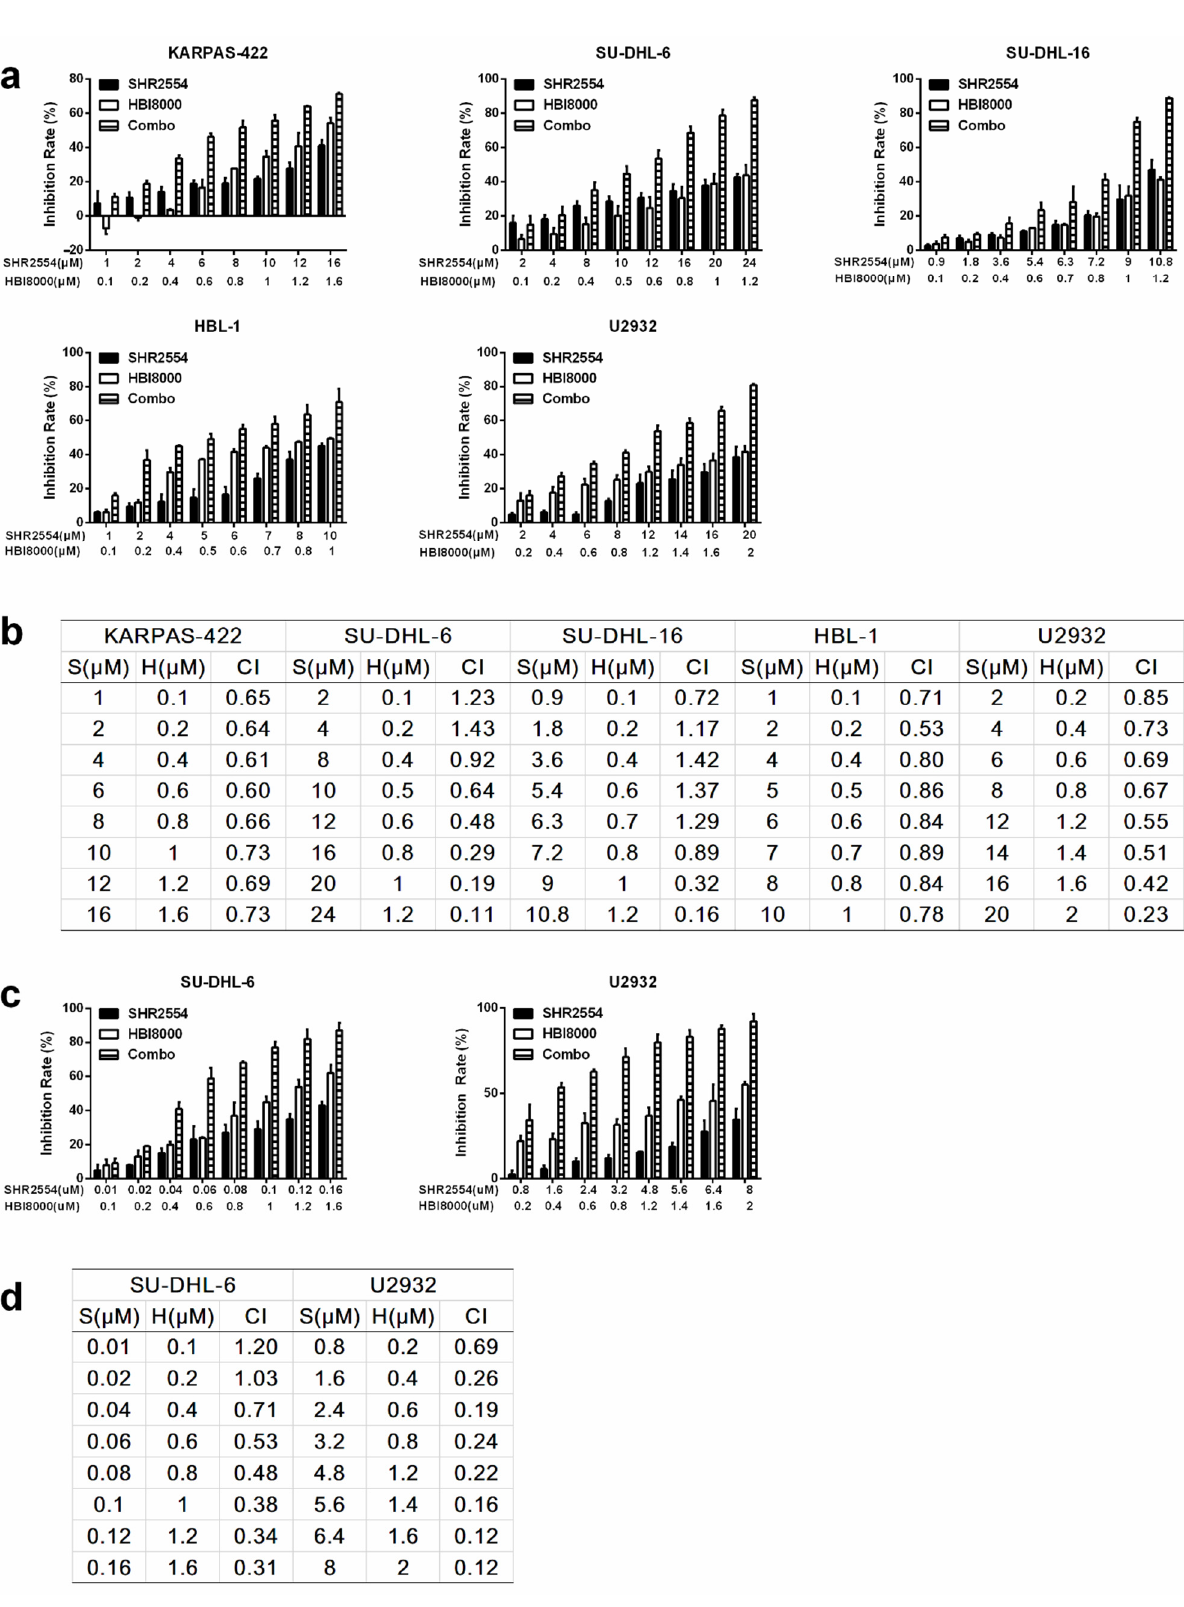
Figure 2. Synergistic effect of SHR2554 and HBI8000 on induction of cell death in DLBCL cell lines. ( a ) Concentrations of SHR2554 and HBI8000 were used for drug combination according to their 72 h IC 50 s in different cell lines and for each cell line, the ratio of SHR2554/HBI8000 was fixed. Cells were treated with indicated concentrations of SHR2554 or HBI8000 for 72 h and cell viability was measured by Cell Titer-Glo luminescent cell viability assay. Inhibition rates were calculated by (1 − dosing/vehicle) × 100%. ( b , d ) Combination index was calculated by CalcuSyn software and CI values < 1